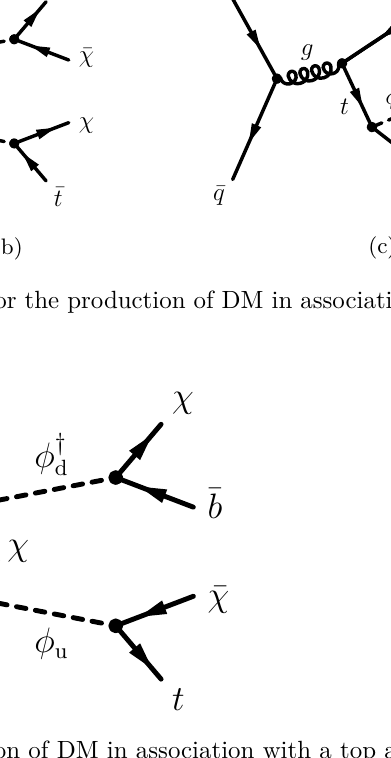
Figure 9 . Feynman diagram for the production of DM in association with a top and a b